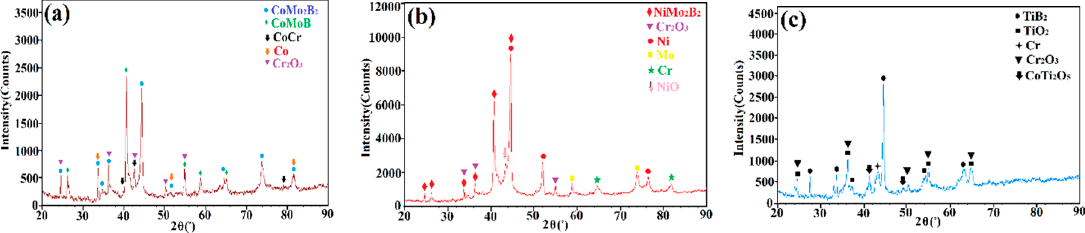
Figure 10. XRD patterns of the boride-based coatings: ( a ) MoB/CoCr, ( b ) MoB/NiCr, and ( c ) TiB/CoCr.